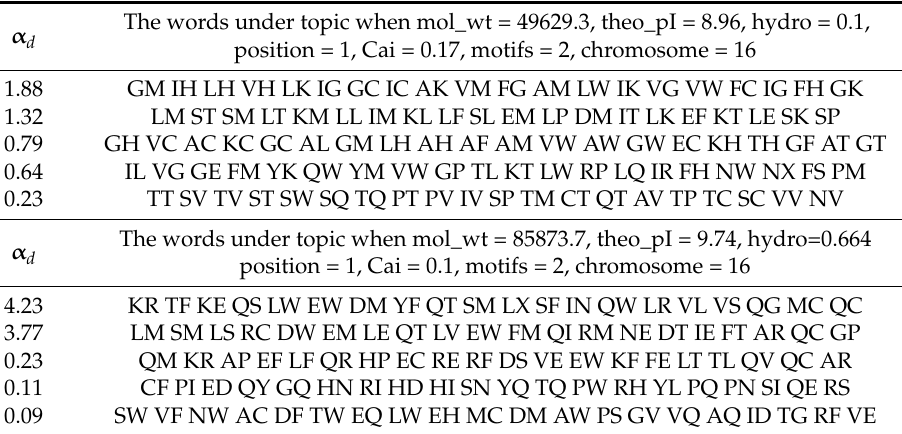
Table 6. The impact on prior parameters of feature variables. The words under topic when mol_wt = 49629.3, theo_pI = 8.96, hydro =